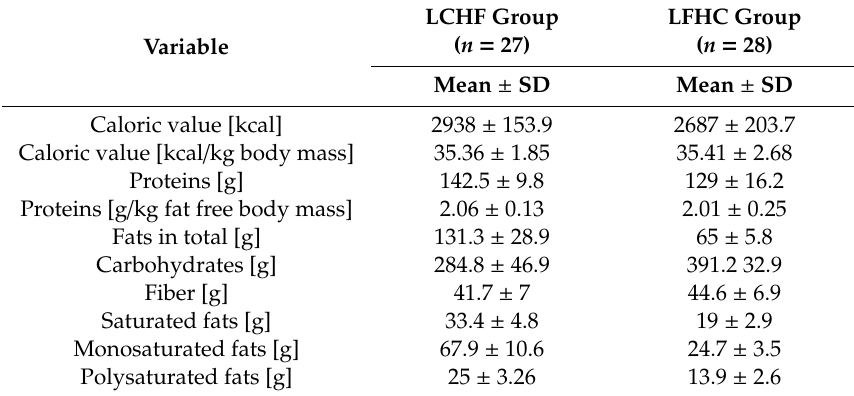
Table 2. Detailed characteristic of interventional